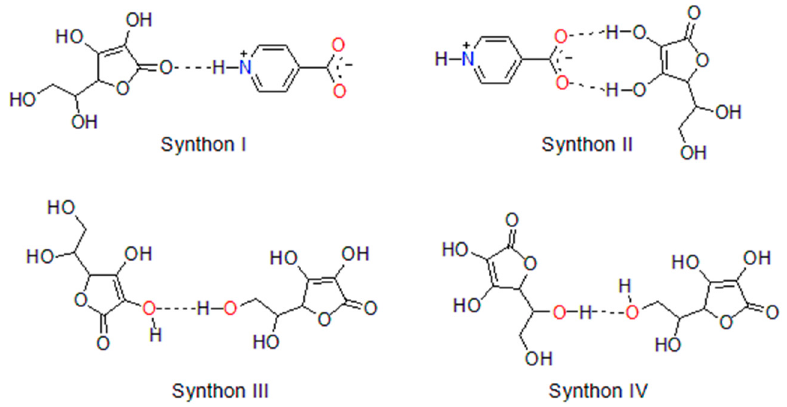
Table 1. Crystallographic data of the VC-INA co-crystal.